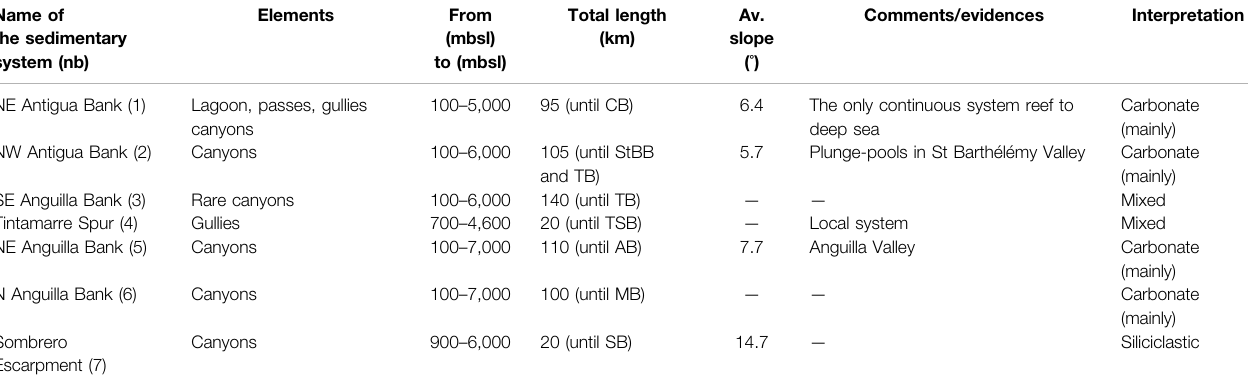
TABLE 2 | Identi fi cation of sedimentary systems (or turbiditic systems) and their nature (siliciclastic/carbonate/mixed) based on morphological and re fl ectance